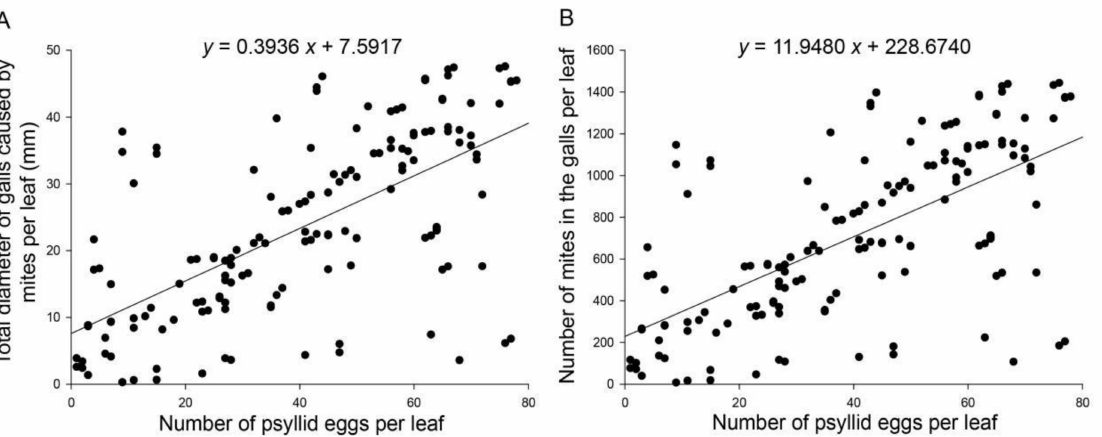
Figure 2. Relationship between A. pallida and B. gobica egg abundances on Goji berry leaves. ( A ) Rela- tionship between the total diameter of galls and the number of psyllid eggs on a leaf; ( B ) Relationship between the number of mites in galls and the number of psyllid eggs on a leaf. The line was fitted using linear regression analysis.